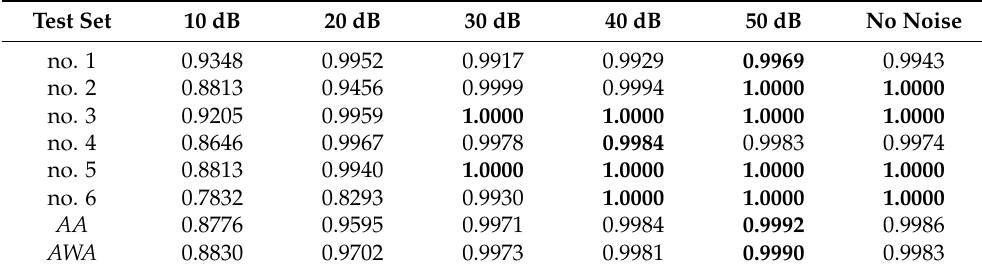
Table 5. The performances corresponding to different noise